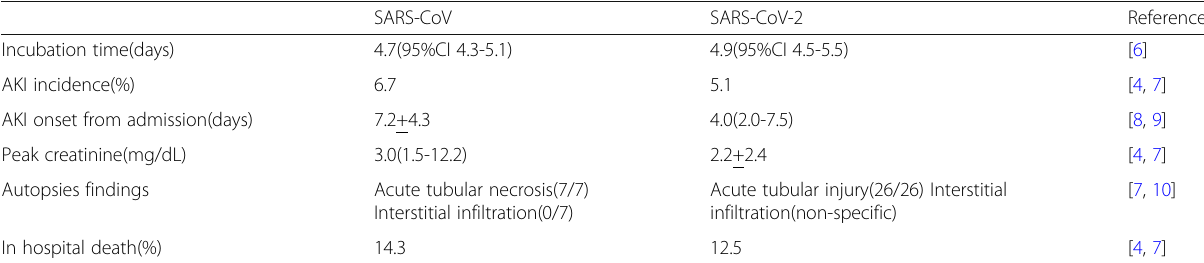
Table 1 Comparison of clinical features and renal complication between SARS and COVID-19. Some data are presented as mean ± SD or median (IQR)